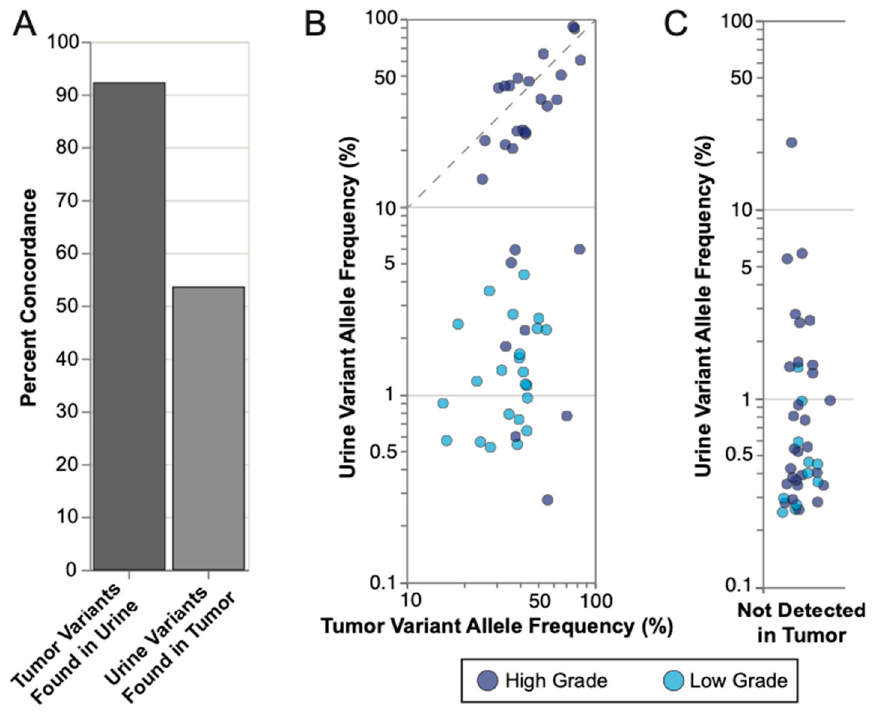
Figure 3. UroAmplitude mutation concordance between tumor and matched urine. ( A ) Median concordance of mutations measured in matched tumor ( n = 18) and urine samples are shown for tumor mutations found in urine and urine mutations found in tumor. ( B ) Concordant mutations were plotted according to their respective VAFs in tumor and urine with high grade (HG) samples in dark blue and low grade (LG) samples in light blue. Significance of mean VAFs was assessed using Mann–Whitney U ( p = 0.0046). The dotted line highlights a 1:1 VAF ratio for Urine and Tumor variants above 10%. ( C ) Urine exclusive events (mutations not found in the tumor) were plotted according to the VAFs with HG and LG samples highlighted.